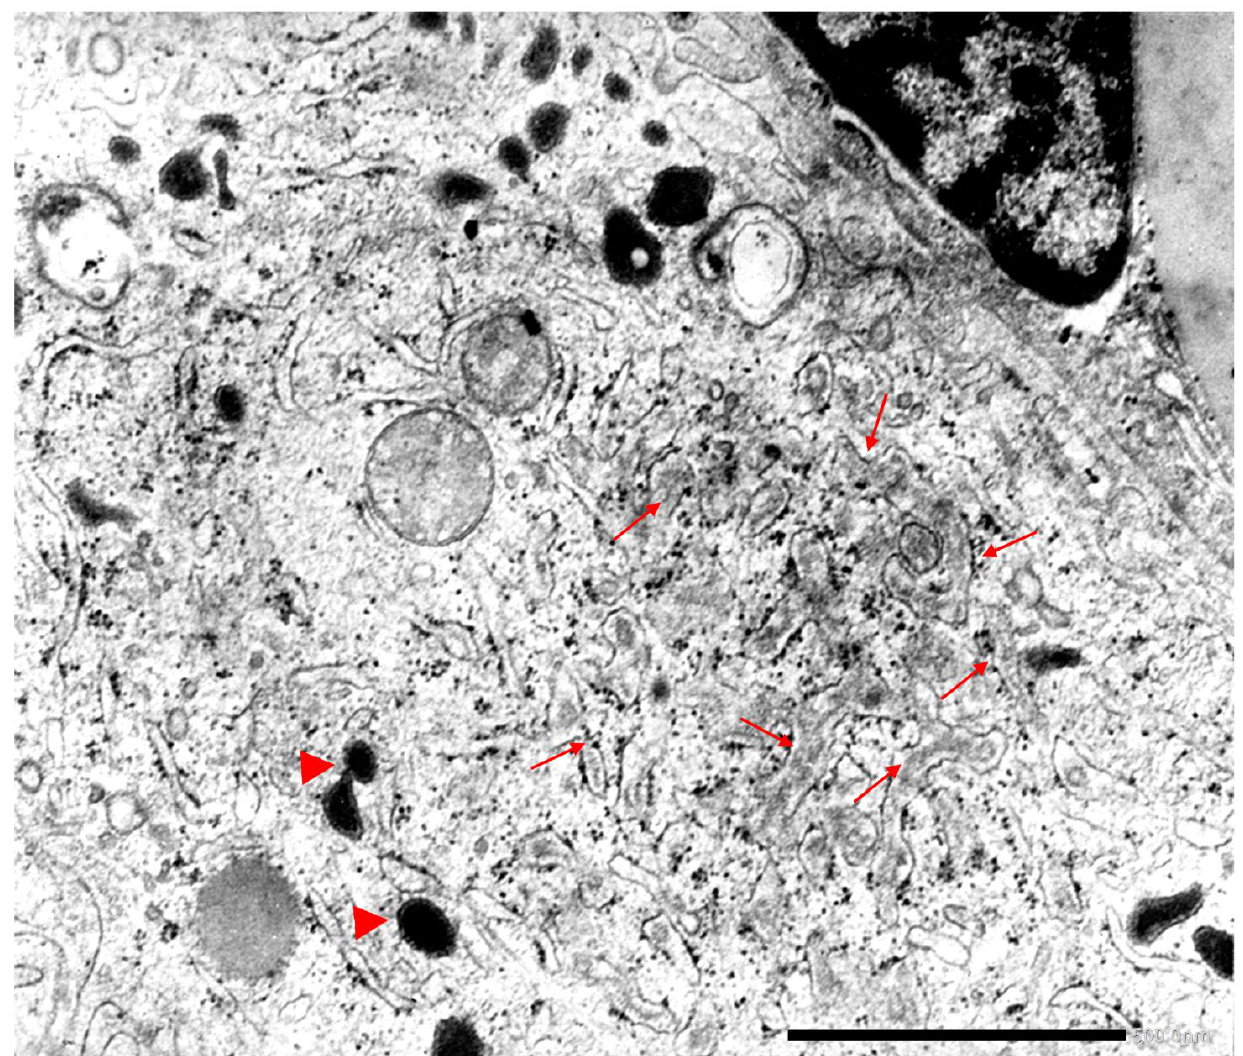
Figure 6. Pi MZ liver. The electronmicrophotograph shows a Kupffer cell with a large cytoplasm containing electron dense bodies (lysosomes) (arrowhead) and a rather well developed ER. The lumen of both RER and SER is slightly dilated and contains amorphous fluffy AAT-like material (arrows). A portion of a perisinusoidal (Ito) cell is present on the top right (EM × 31,025). (Figure obtained from Callea F. PhD thesis, Acco, Leuven, 1983: 1–153).